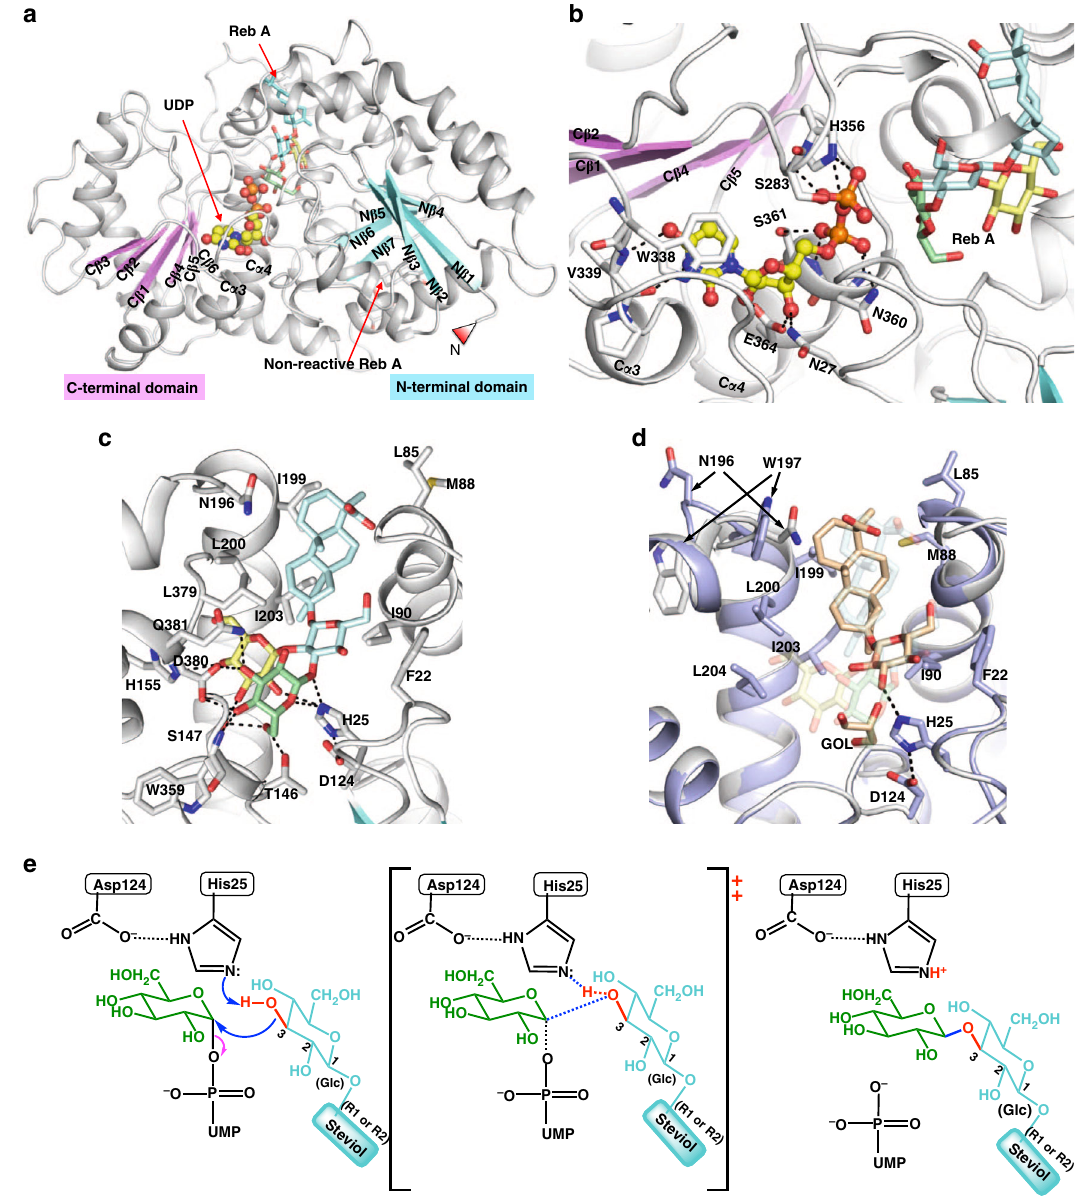
Fig. 5 The structure of UGT76G1 and analysis of the active site. a The overall structure of UGT76G1. The structure is shown in cartoon representation. The β -sheet of the N-terminus is shown in cyan and that of the C-terminus in pink. The bound UDP is shown in stick-ball mode with carbons colored yellow, oxygen red and nitrogen blue. Two molecules of the steviol compound Reb A are shown in stick representation with oxygen colored red, carbons of the nonreactive Reb A colored white, carbons of the reactive Reb A colored differently, carbons of steviol aglycone and the glucose A in cyan, the glucose B in light yellow and the incoming glucose C in pale green. b The binding pocket of UDP in the presence of Reb A with atoms colored as shown in Fig. 5a. The hydrogen bonds are shown by dashed lines. c The binding pocket of the reactive Reb A. d Comparison of the ternary complex structures with Rubu and Reb A. Two ternary complex structures are shown in cartoon representation with the proteins in light blue (Rubu) and white (Reb A). The residues associated with Rubu are shown in stick representation with carbons colored light blue, oxygen red and nitrogen blue. Two residues, Asn 196 and Trp 197, in the structure of Reb A are shown in stick representation with carbons colored white, which highlight the fl exible loop between Ser 195 and Lys 201. Rubu and a glycerol molecule (GOL) in the active site are shown in stick with carbons colored gold, while Reb A is shown in a transparent stick representation after overlapping their ternary complex structures. The glycerol molecule occupies a similar position of the incoming glucose C of Reb A. e The S N 2 mechanism of UGT76G1 catalysis. His 25, with the aid of Asp 124, speci fi cally deprotonates the 3-hydroxyl of the glucose A and makes it a nucleophile to attack the sugar donor UDPG. The transition state of the S N 2 mechanism is shown in the